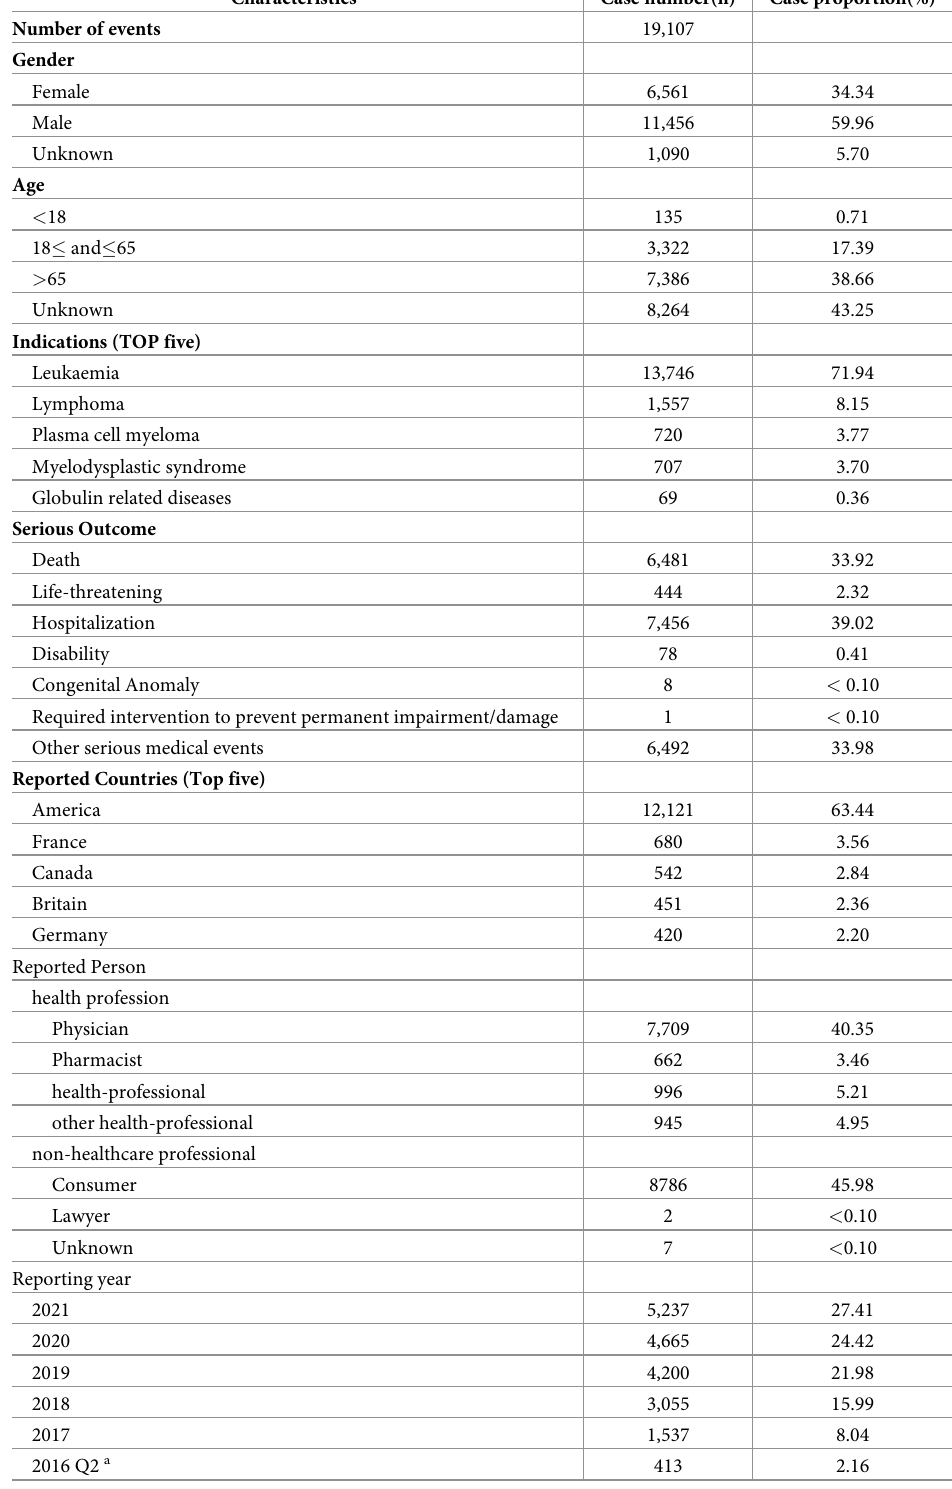
Table 1. Characteristics of reports associated with venetoclax from 2016 Q2 to